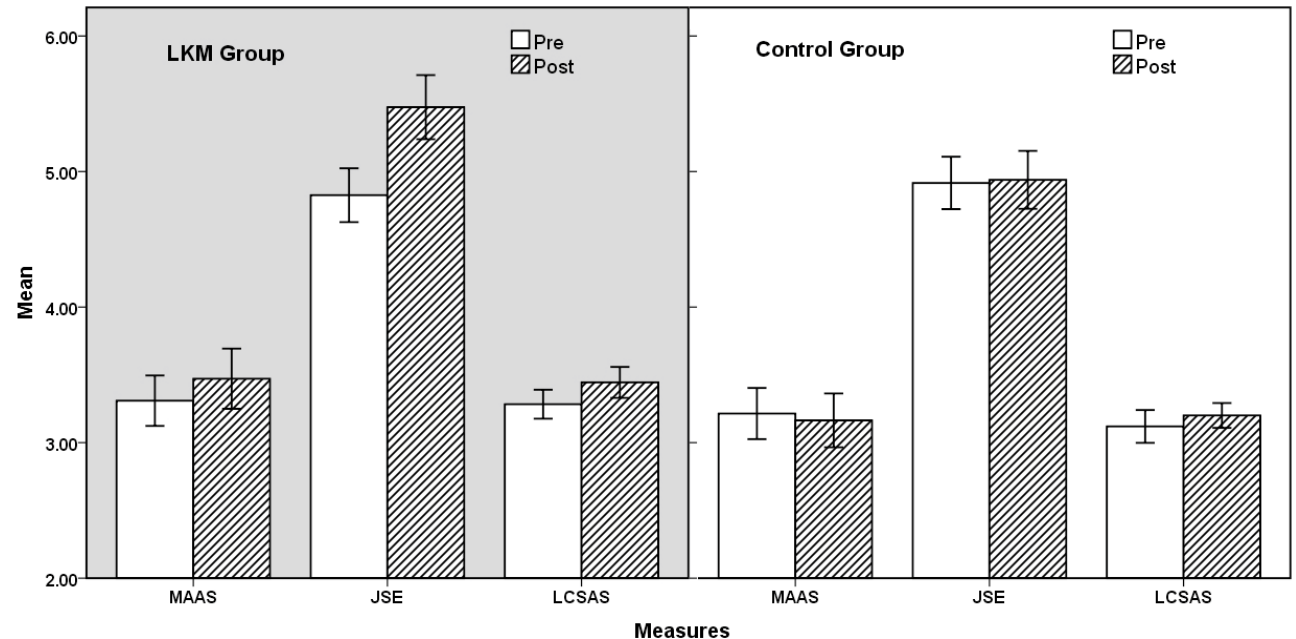
Figure 2. Comparison of three measures between the loving-kindness meditation (LKM) and control groups. MAAS, Mindfulness Attention Awareness Scale; JSE, the Jefferson Empathy Scale; LCSAS, Liverpool Communication Skills Assessment Scale.